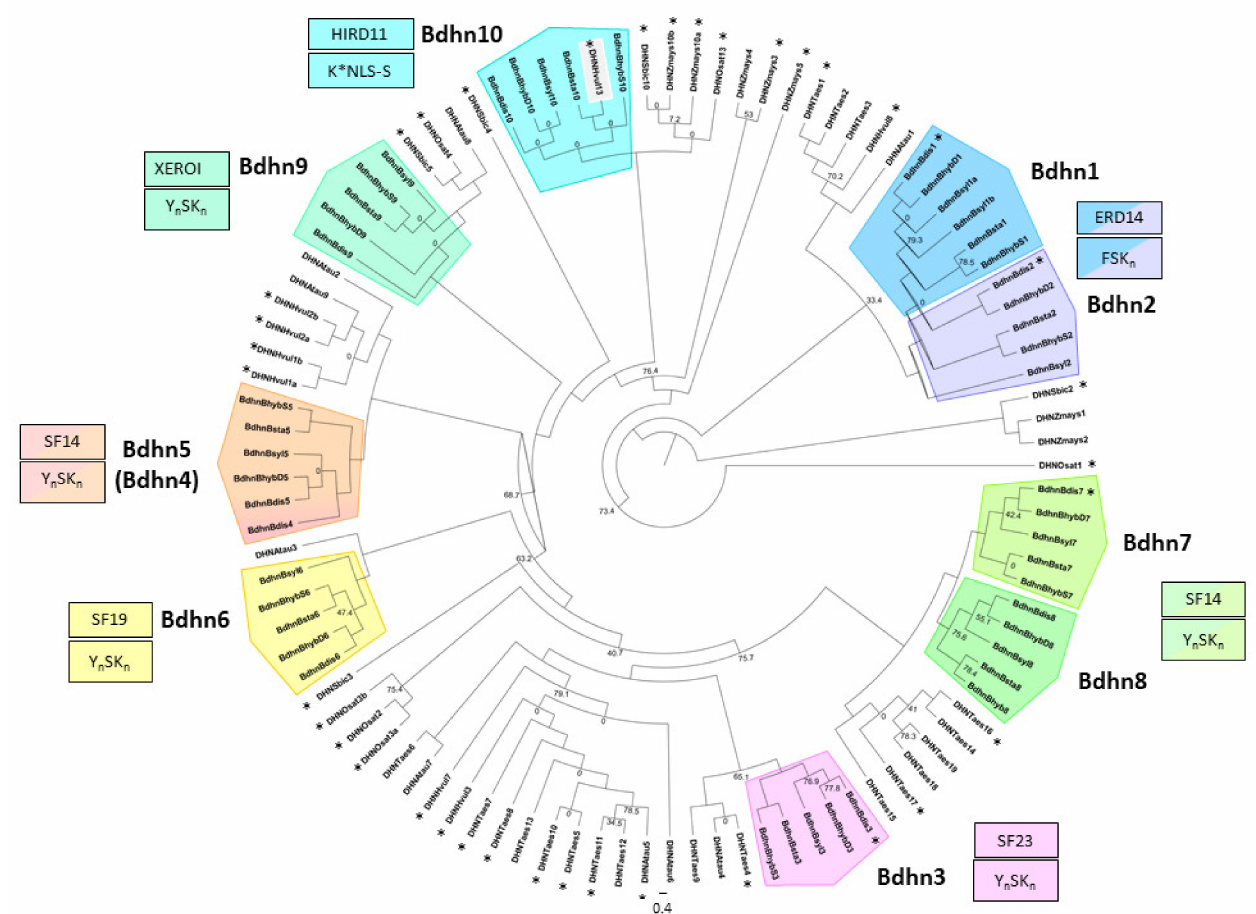
Figure 2. Maximum likelihood Brachypodium Bdhn tree. Unrooted IQtree cladogram showing the relationships among the dehydrin Bdhn gene clades and orthologous grass sequences (Atau: Aegilops tauchii ; Hvul: Hordeum vulgare ; Osat: Oryza sativa ; Sbic: Sorghum bicolor ; Taes: Triticum aestivum ; Zmays: Zea mays ) and among Brachypodium species and genomes within each clade. Bdhn clades are identified by colors, Bdhn codes, gene architecture, and Panther subfamily codes (see Table 1). Duplicated Bdhn genes form sister clades or fall within the same clade. Ultrafast bootstrap support (<80%) is shown on branches; the remaining branches are fully supported. Asterisks indicate dehydrin genes differentially expressed under drought vs. control conditions (see text and Supplementary Table S10). Scale bar: number of mutations per